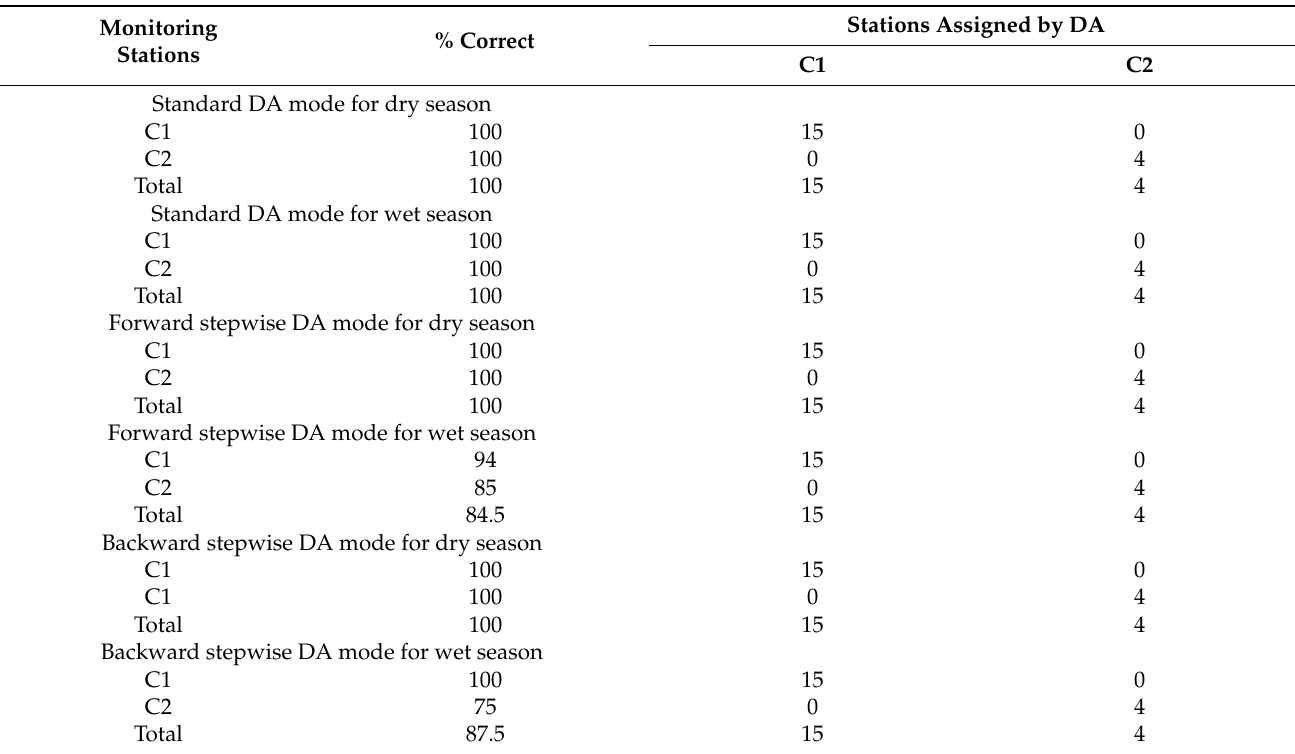
Table 8. Classification matrix for standard, forward stepwise, and backward stepwise DA of spatial variation in LHW for both dry and wet seasons, showing percentage of correct assignation for discriminating